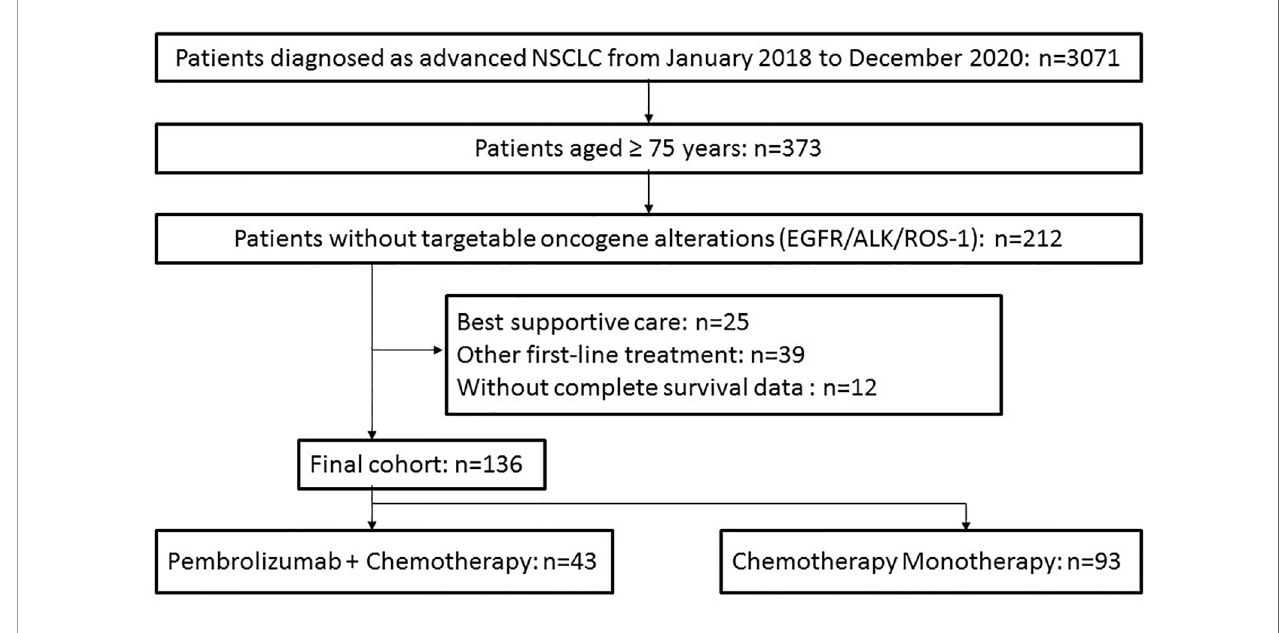
FIGURE 1 | Flow diagram of patient selection steps.